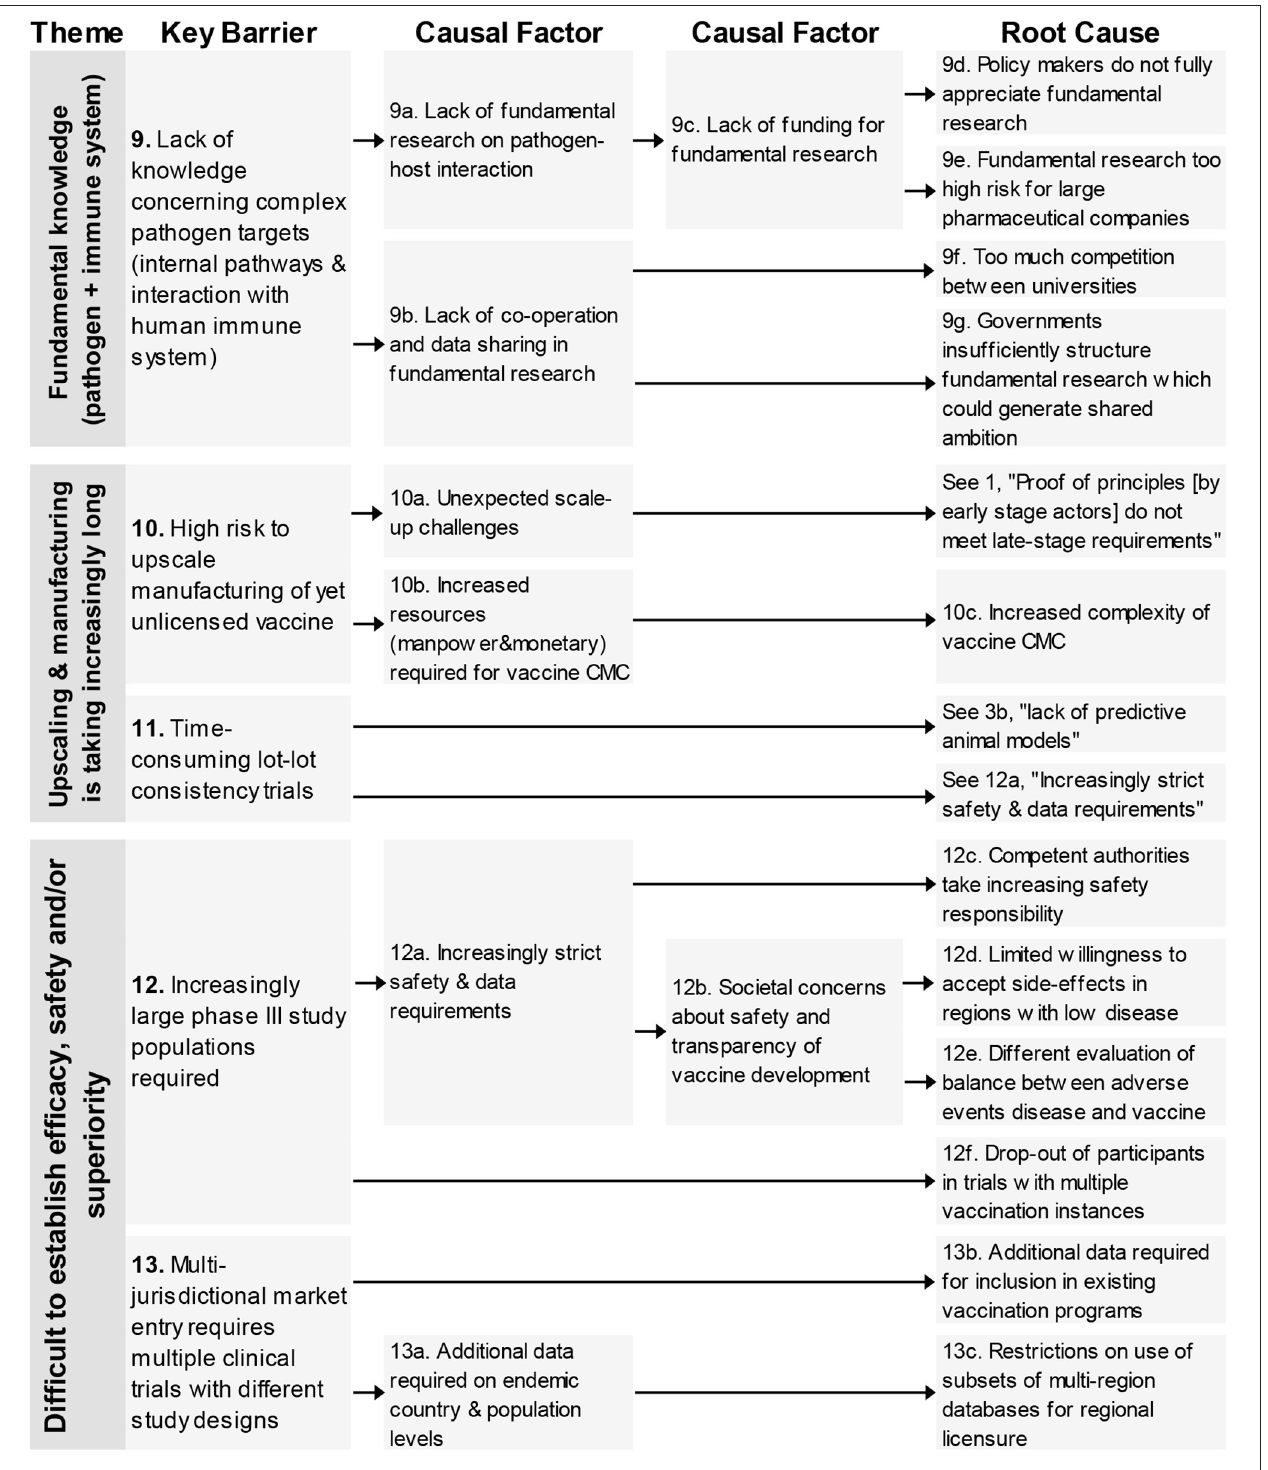
FIGURE 3 | Root-cause analysis of the three barrier themes classified under the themes “Fundamental Knowledge on pathogen and immune system,” “Upscaling & manufacturing is taking increasingly long” and “Difficult to establish efficacy, safety, and/or superiority” (Part 1). Columns are causally structured. (Left) key barriers are listed that are caused by causal factors (middle), which in turn find their origin in root causes (right).